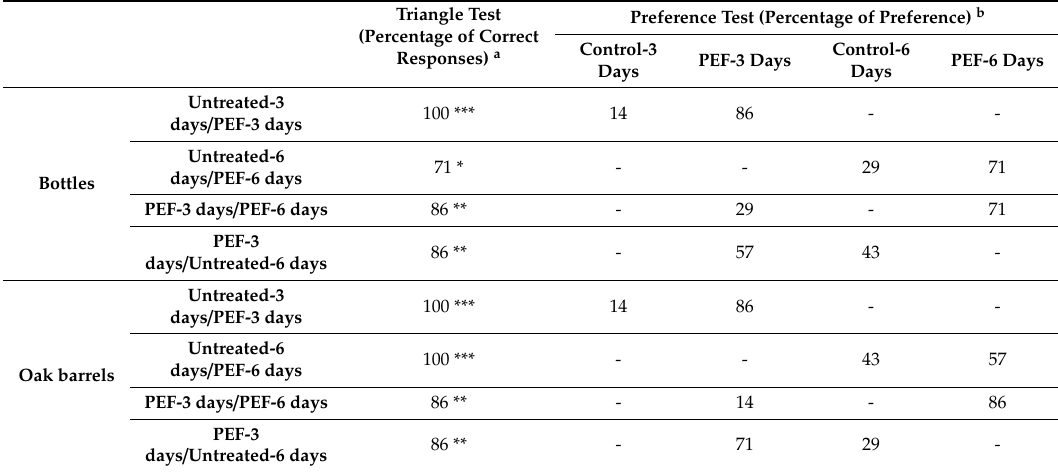
Table 4. Triangle test and percentage of preference for each of the comparisons among wines obtained from untreated and PEF-treated grapes with 3 and 6 days of maceration after aging in bottles (12 months), and in oak barrels (6 months) followed by bottle aging (6